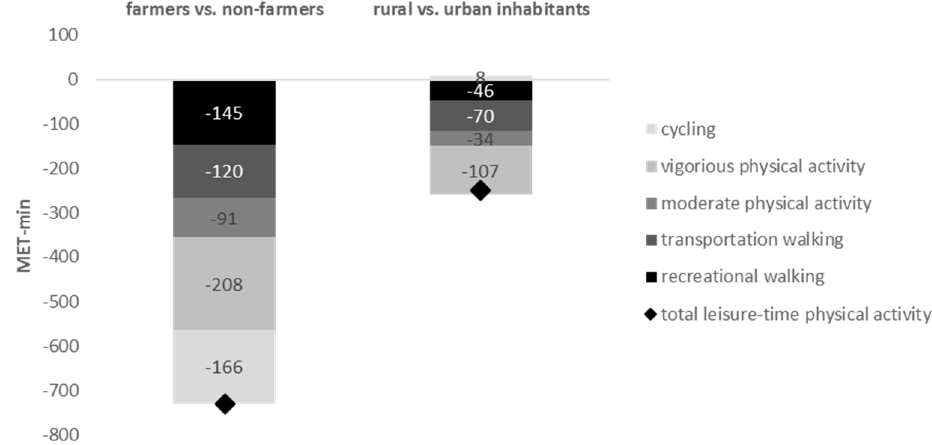
Figure 2. Decomposition of the total physical activity gap by types of activity. Please provide a clearer figure.